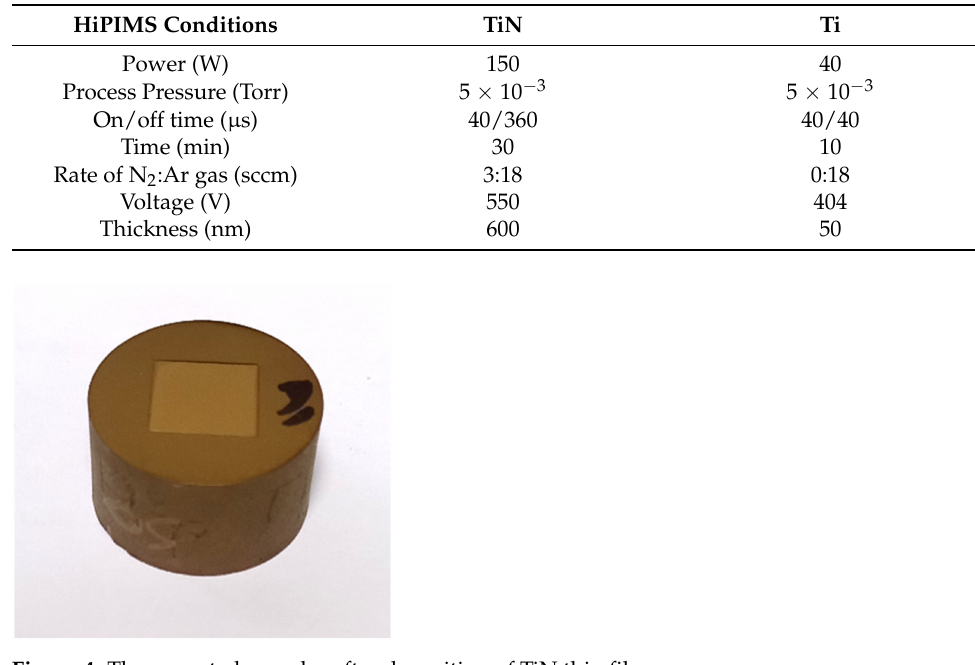
Figure 4. The mounted samples after deposition of TiN thin